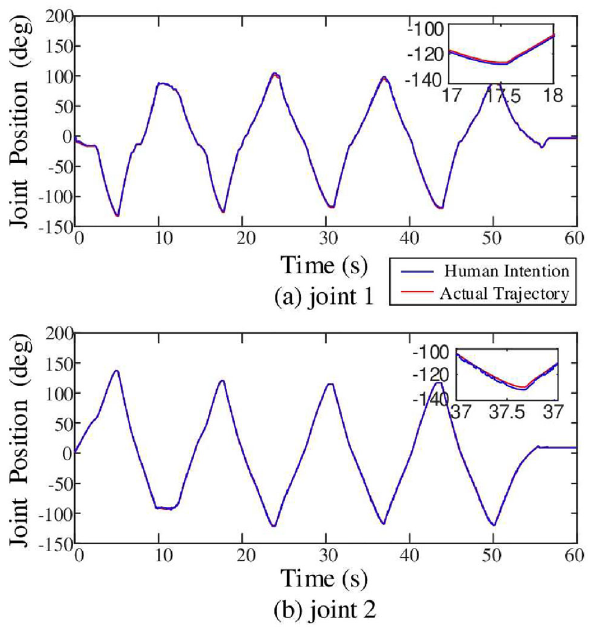
Fig. 9 Joint position tracking curves under existing decentralized inte- gral sliding mode control method